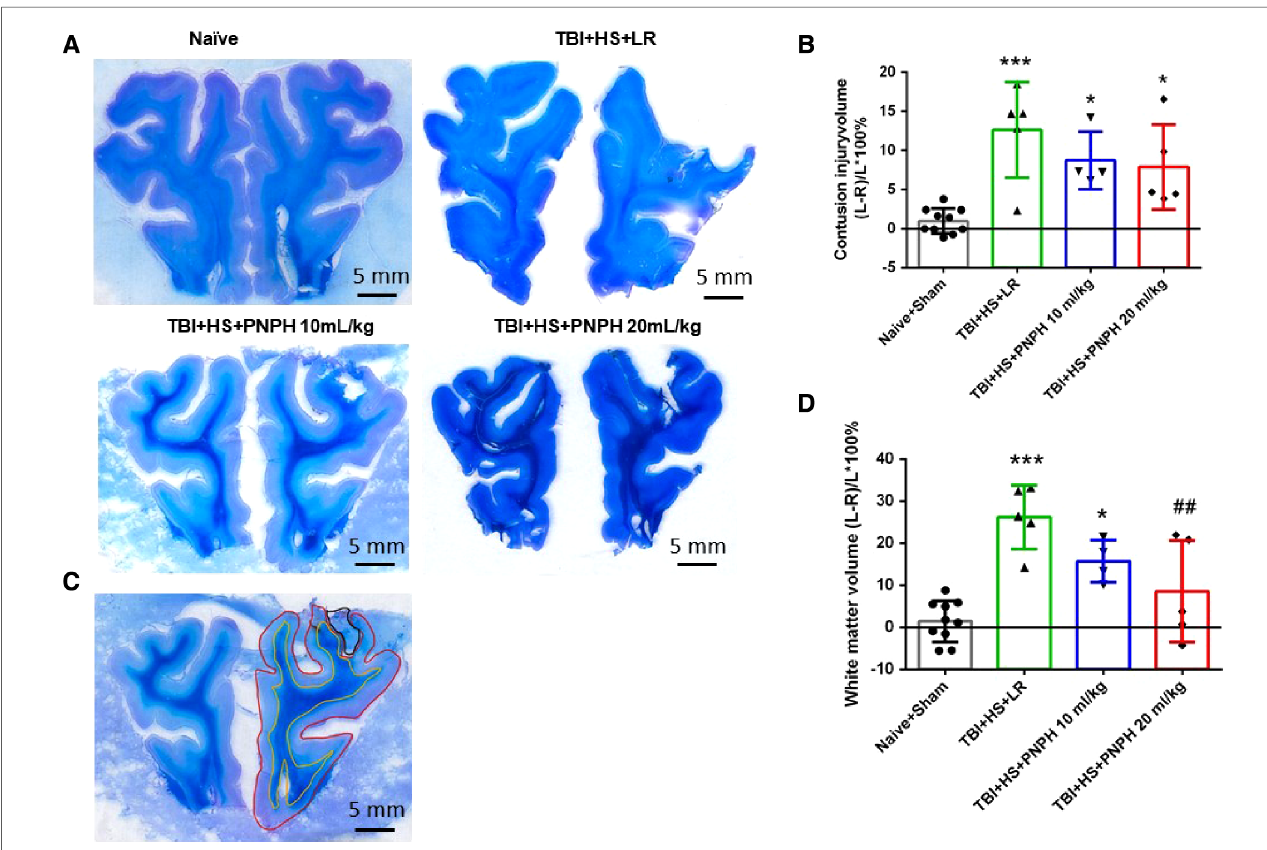
FIGURE 3 Effect of PNPH on contusion injury volume and volumetric white matter loss in frontal lobe after TBI+hemorrhagic shock (HS). ( A ) Representative coronal sections (both hemispheres, top is superior) of frontal lobe of normal pig brain and brains 4 days after TBI and resuscitation with 60 ml/kg lactated Ringer ’ s (LR) solution and 10 and 20 ml/kg PNPH. Gray matter is visualized with cresyl violet staining and subcortical white matter myelin is visualized with Luxol fast blue staining. ( B ) Area delineated by red trace is the entire histologically normal hemisphere, area delineated by the yellow trace is the subcortical white matter, and area circled by the black trace is the contusion site. ( C ) Contusion injury volume (intact tissue difference of left minus right hemisphere as a percentage of left hemisphere volume contralateral to the injury site) of pigs subjected to TBI+HS followed by resuscitation at 120 min with LR ( n =5) or 10 ml/kg PNPH ( n =4) and 20 ml/kg PNPH ( n =5). The normal variation in the difference of left minus right hemisphere volume as a percentage of left hemisphere volume is shown for the combined Naïve ( n =5) and Sham ( n =5) group. ( D ) Volume of white matter loss in the same brains was calculated as the difference between left minus right subcortical white matter volume normalized by the left subcortical white matter volume (contralateral volume). The loss of white matter seen in the LR group was attenuated in the 20 ml/kg PNPH group. Mean±SD and individual data for each pig are shown. * P <0.05, *** P <0.001 vs. combined Naïve and Sham groups. ## P <0.05 vs. LR group determined by one-way ANOVA and the Holm-Sidak procedure for multiple